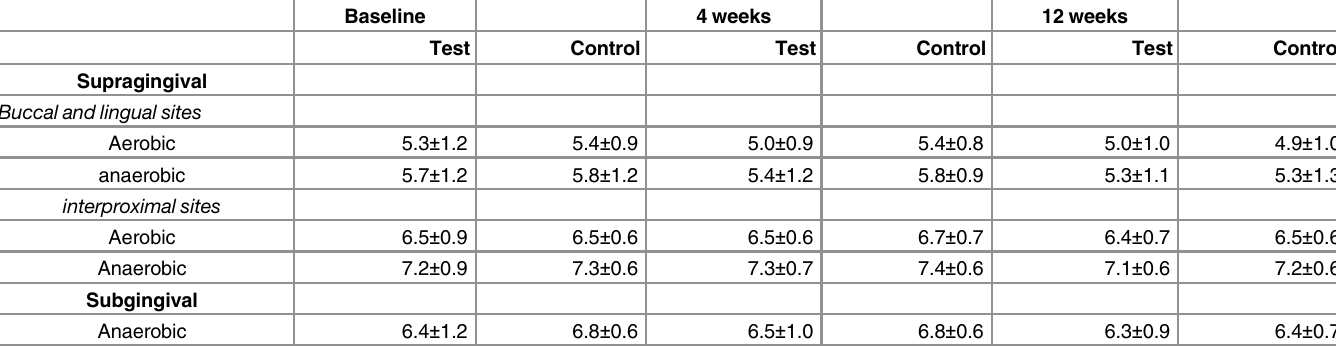
Table 3. Microbiological results at baseline and follow ups (means ± SD). Log – transformed bacteria counts.